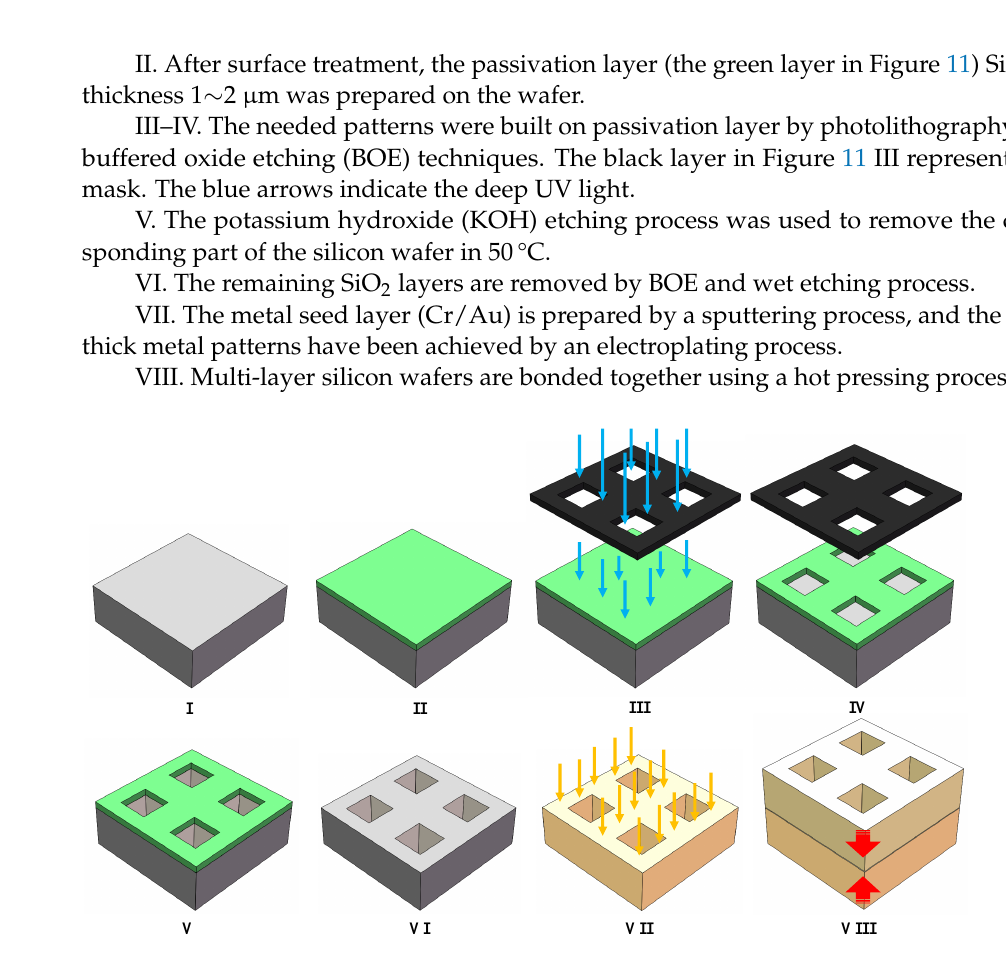
Layer 1 contains 16 output ports whose sizes are non-standard, which also work as parts of the 90 ◦ transitions. Layer 2 is the air-filled 16-way RWG power divider,